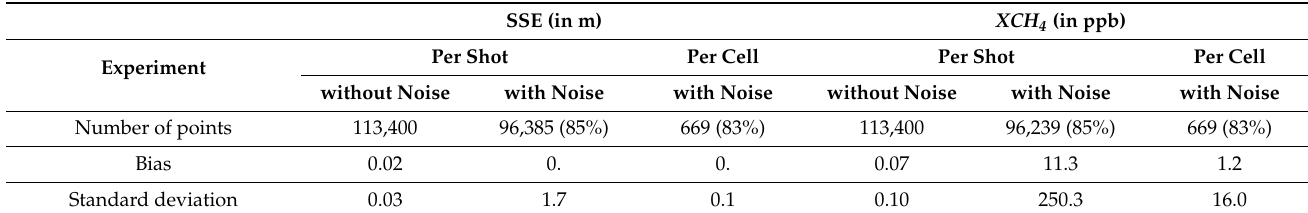
Table 6. For the experiments with and without instrumental noise, per shots and per 50 km cell, the differences between retrieved SSE and XCH 4 and their references in terms of mean bias and mean standard deviation calculated over the number of points for which XCH 4 can be retrieved (points with sufficient signal due to sufficient reflectivity). SSE (in m) XCH 4 (in ppb)